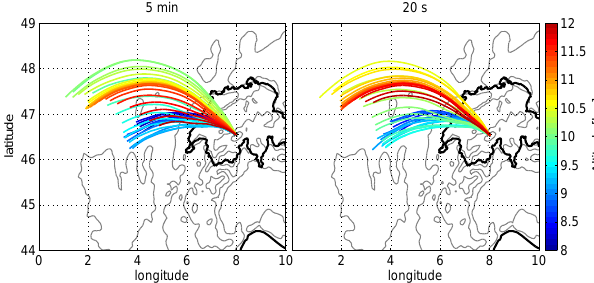
Figure 2. Offline (left) and online (right) trajectories arriving above Jungfraujoch at 09:00UTC on 22 November 2011. Offline trajecto- ries: based on 5min wind field data. Trajectory lengths: plotted for 10h or until they leave the domain. Colour coding: trajectory alti- tude upon their arrival above Jungfraujoch. Thick contours: Swiss border as well as coast of the Mediterranean Sea. Grey contour lines: topography from the COSMO-2